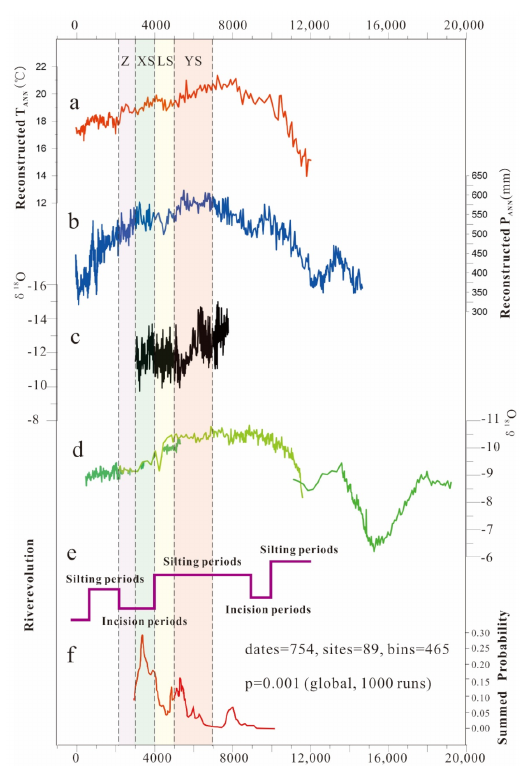
Figure 6. The Holocene climate change, fluvial landform evolution and the SPD of radiocarbon dates in Central China. ( a ) Holocene temperature reconstruction in the location (141.8 ◦ E, 36 ◦ N) [48]; ( b ) Holocene precipitation reconstruction from Gonghai Lake [51]; ( c ) δ 18 O record of stalagmite from the southeastern Fergana Valley [52]; ( d ) δ 18 O record of stalagmite from Sanbao Cave [53]; ( e ) the regional fluvial landform evolution [49]; ( f ) the SPD of radiocarbon dates indicated that there was a cultural trough during 5.0–4.5 ka BP in Central China